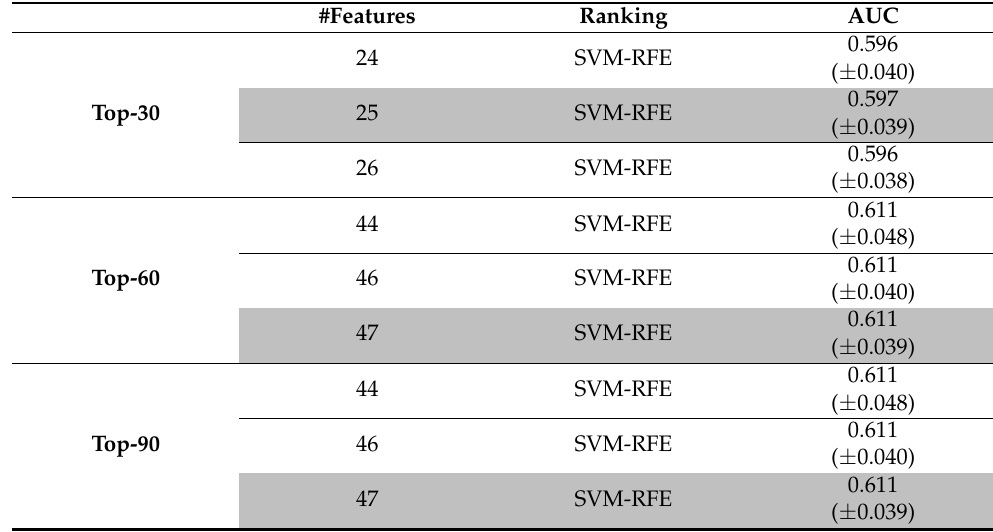
Table 2. SVM classifier. In gray background the number of features with the best result.